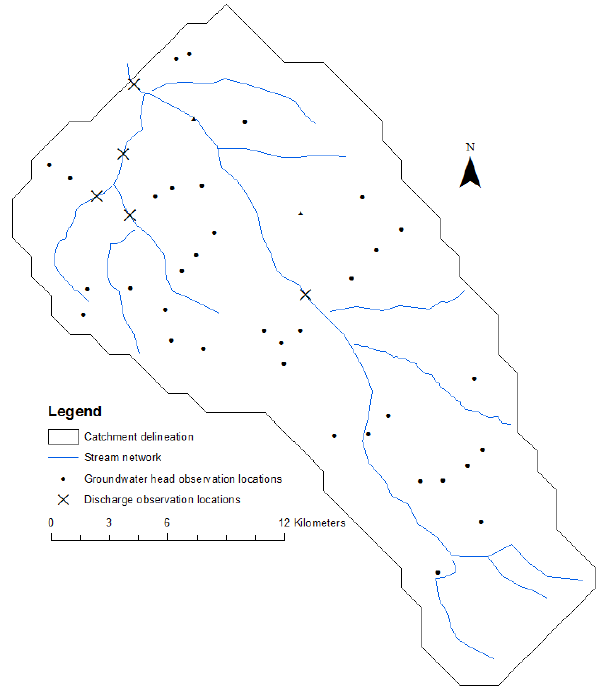
Figure 1. Karup catchment with locations of synthetic discharge and hydraulic head